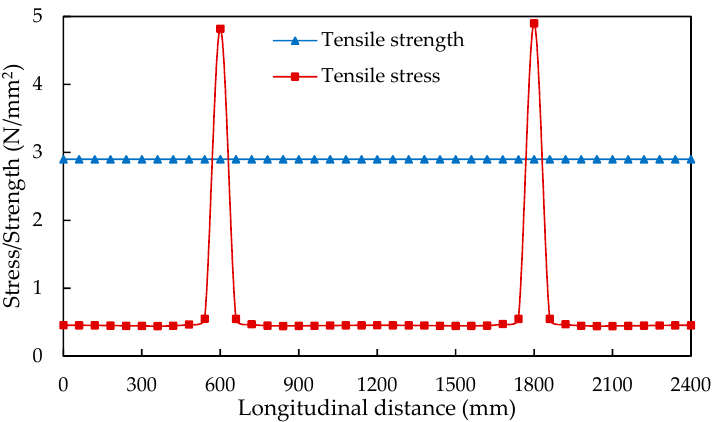
Figure 6. Development of maximum tensile stress against tensile strength over the saw-cut tips along the length of pavement.